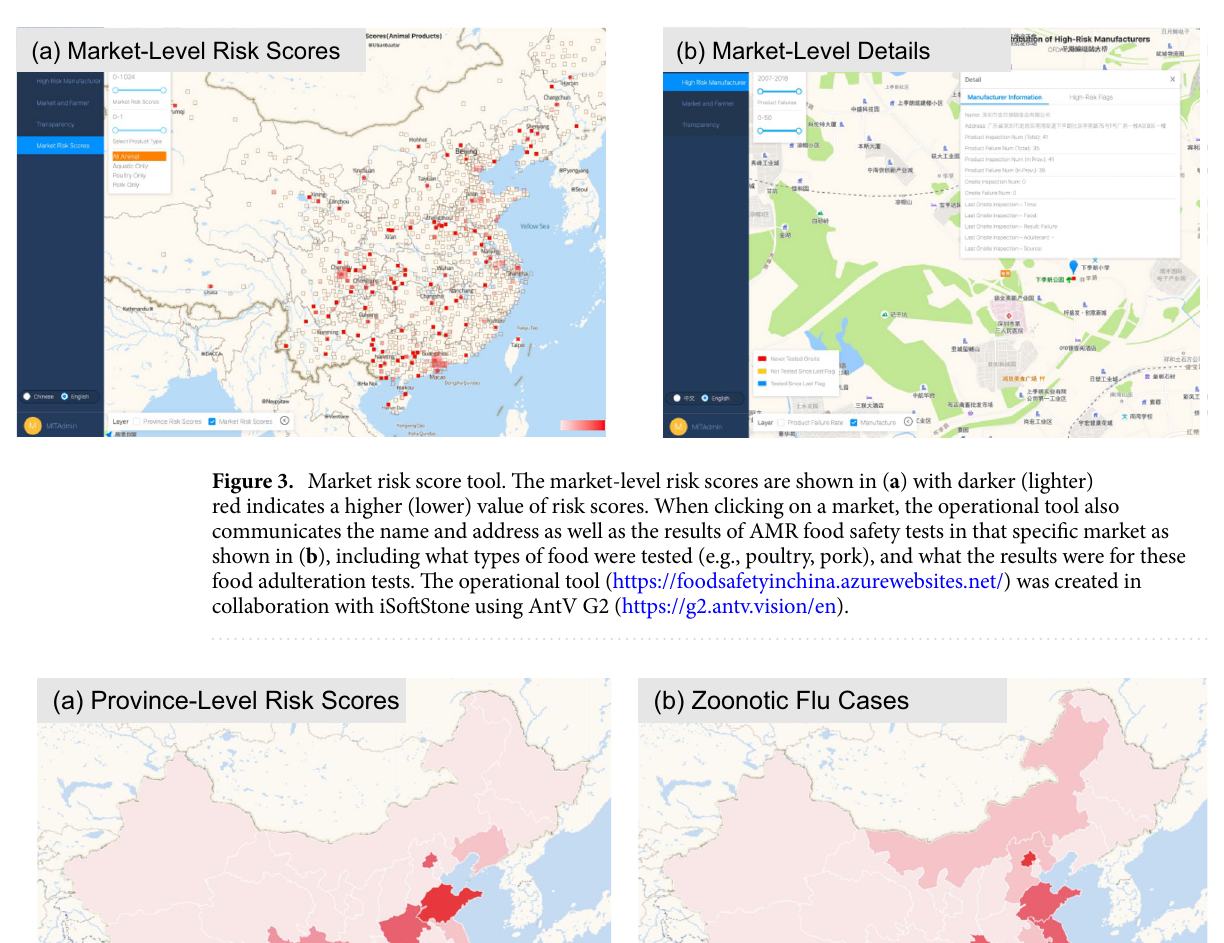
Association between provincial food adulteration risk scores and zoonotic disease risk. The correlation between province-level risk scores and respective zoonotic flu isolates (cases) in humans is shown in Fig. 4. A linear regression model is used to evaluate association of province-level risk scores with zoonotic influenza cases in humans, while controlling for covariates, such as livestock production, slaughter, and the distribution of markets in each province. All model variables and descriptions and the best-fit linear regression model are shown in Tables 1 and 3, respectively. The best-fit model achieves an AIC of 268.59, and the benchmark model (only using control variables) an AIC of 275.33. This AIC improvement exceeds the common heuristic of 2.0 used to show model improvement 32 . The in-sample coefficient of determination (R 2 ) improves from 0.421 to 0.534 with the addition of the key inde- pendent variable (number of AMR tests at high-risk markets). Furthermore, as observed in Table 3, the model coefficient for AMR tests at high-risk markets is significant (p < 1 * 10 –5 ). Risk scores at specific markets implicated in spreading zoonotic disease. Zoonotic disease out- breaks have been tied to specific markets twice per literature review. Specifically, the Wuhan Huanan Seafood Market , associated with the first COVID-19 cluster, is among the top 6% of risky markets 11 . Likewise, the Beijing